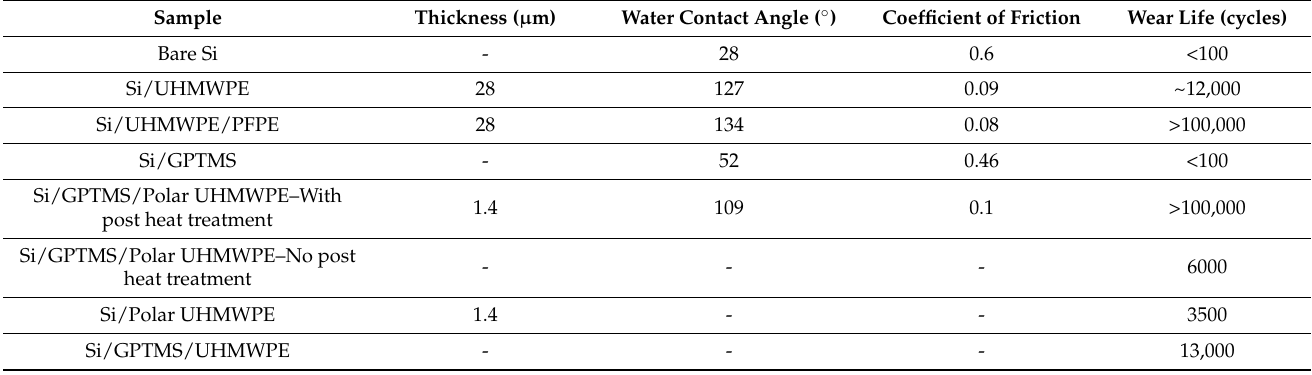
Table 2. Summary of the results from Satyanayana et al.